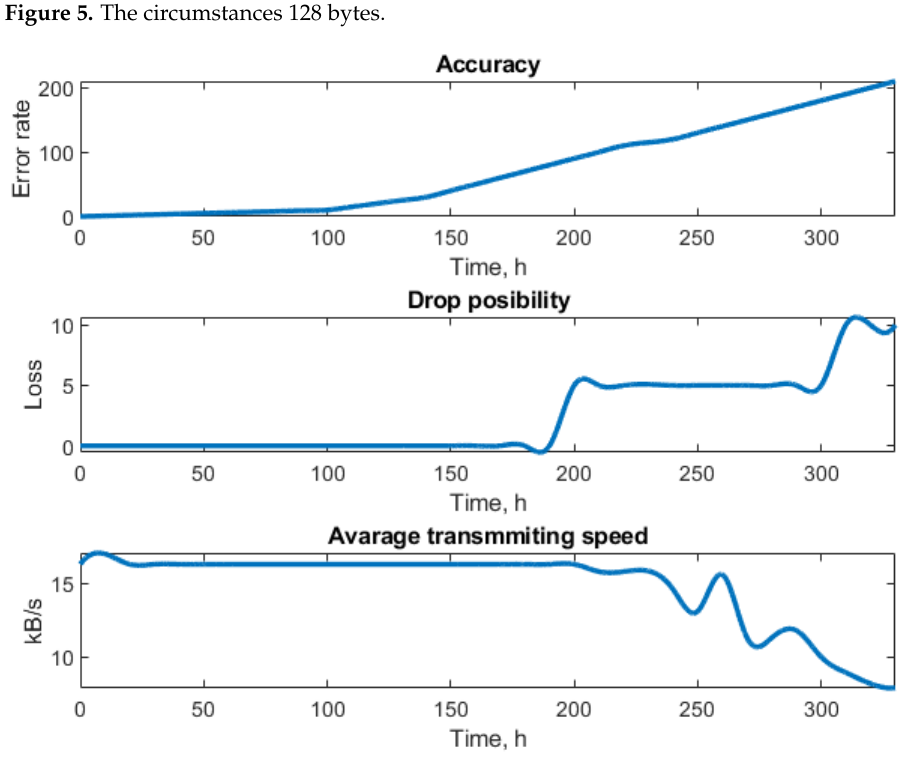
Figure 5. The circumstances 128 bytes.